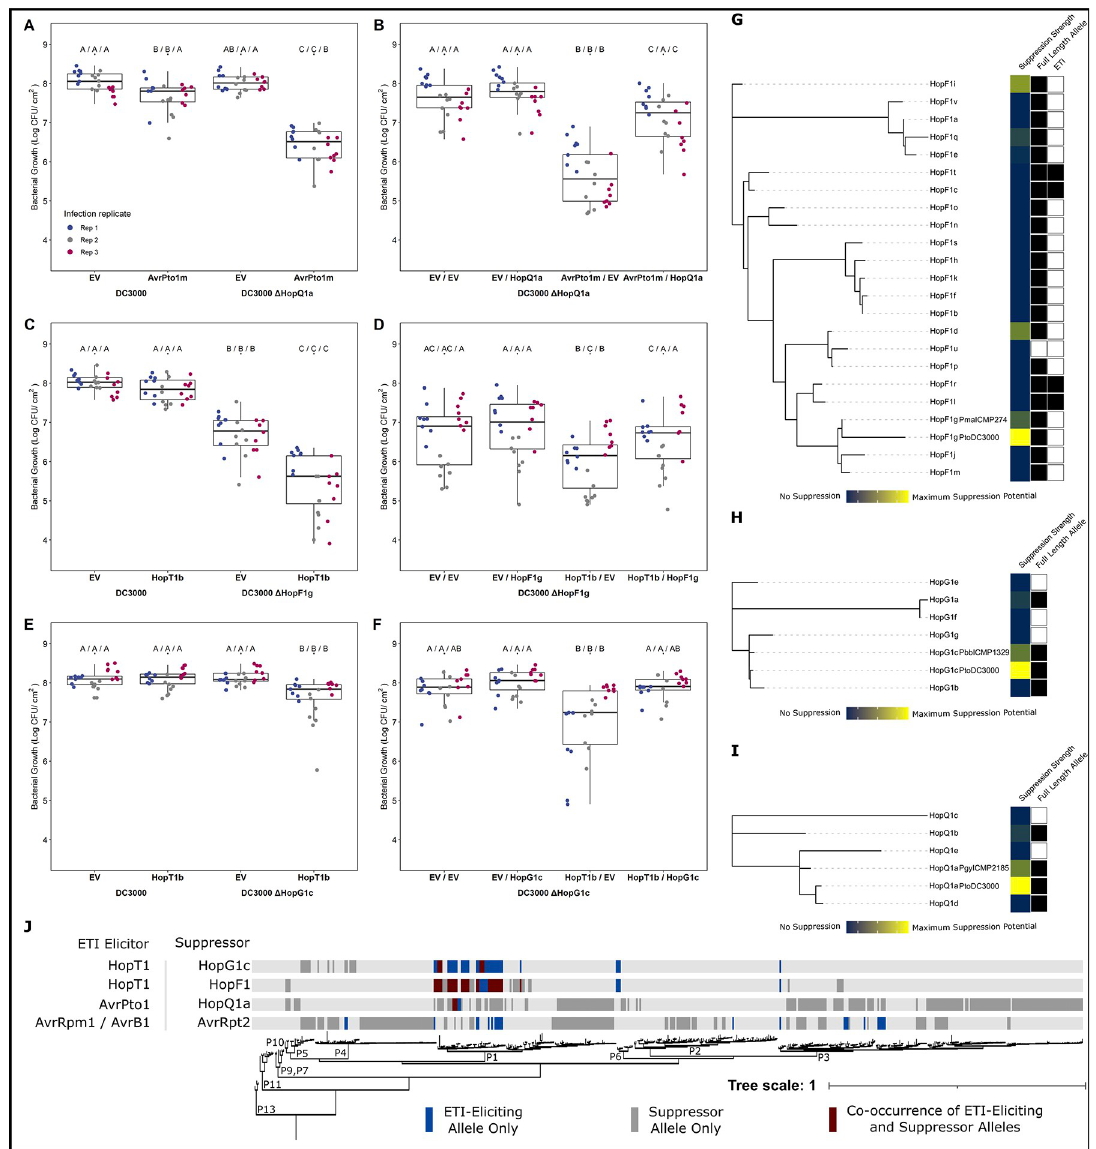
Fig 5. Modulation of ETI load in P . syringae . Comparative bacterial growth assays and subsequent complementation of (A-B) AvrPto1m in PtoDC3000 vs. PtoDC3000 Δ HopQ1a, (C-D) HopT1b in PtoDC3000 vs. PtoDC3000 Δ HopF1g, and (E-F) PtoDC3000 Δ HopG1c. Letters represent statistically significant differences (Tukey’s HSD, P < 0.05). Statistical tests were performed independently for each replicate. Maximum likelihood PsyTEC representative allele T3SE family trees for (G) HopF1, (H) HopG1, and (I) HopQ1, including the PtoDC3000 allele. The first metadata column shows relative ETI suppression strength using the DC3000 allele as reference for maximum suppression (yellow to blue represent high to low suppression). The second metadata column identifies full length alleles, with filled squares representing alleles whose amino acid length is at least 75% the family average. The third metadata column show HopF1 ETI elicitors (filled squares). (J) Co-occurrence of ETI elicitor—suppressor pairs across the P . syringae core genome phylogeny [9,47].The presence of solely an ETI elicitor allele from an ETI elicitor—suppressor pair is denoted in blue, the presence of solely the suppressor is denoted in grey, and co-occurrence of both components of an ETI—suppressor pair is denoted in